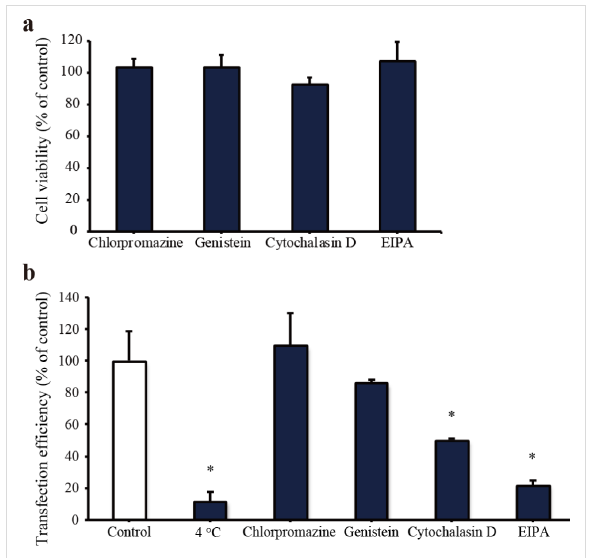
Figure 4: (a) Cytotoxicity assay of HL-1 cells incubated with endo- cytosis inhibitors for 24 h. (b) Effects of the endocytosis inhibitors on the transfection efficiency of HAp/pEGFP complexes into HL-1 cells. Values are presented as the mean ± SD ( n = 4). * p <